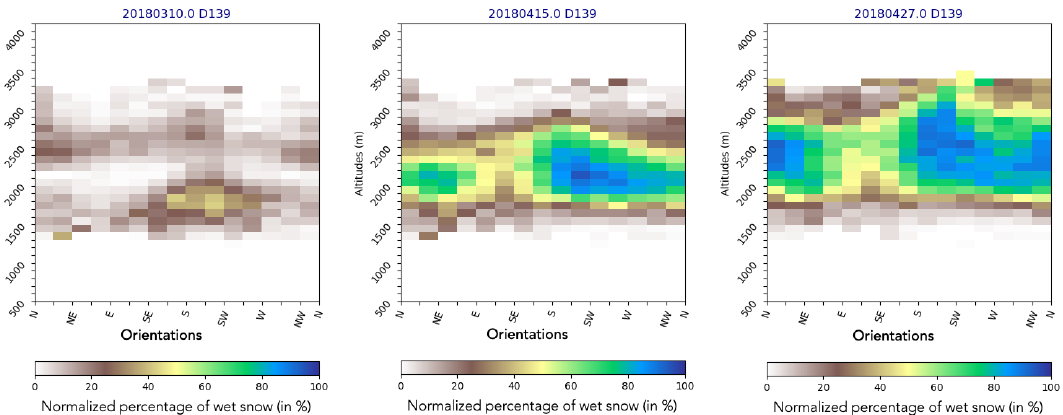
Figure 9. Sentinel-1 wet snow meltlines from the descending orbit D139 for spring 2017: 15 March 2017, 14 April 2017 and 26 April 2017.